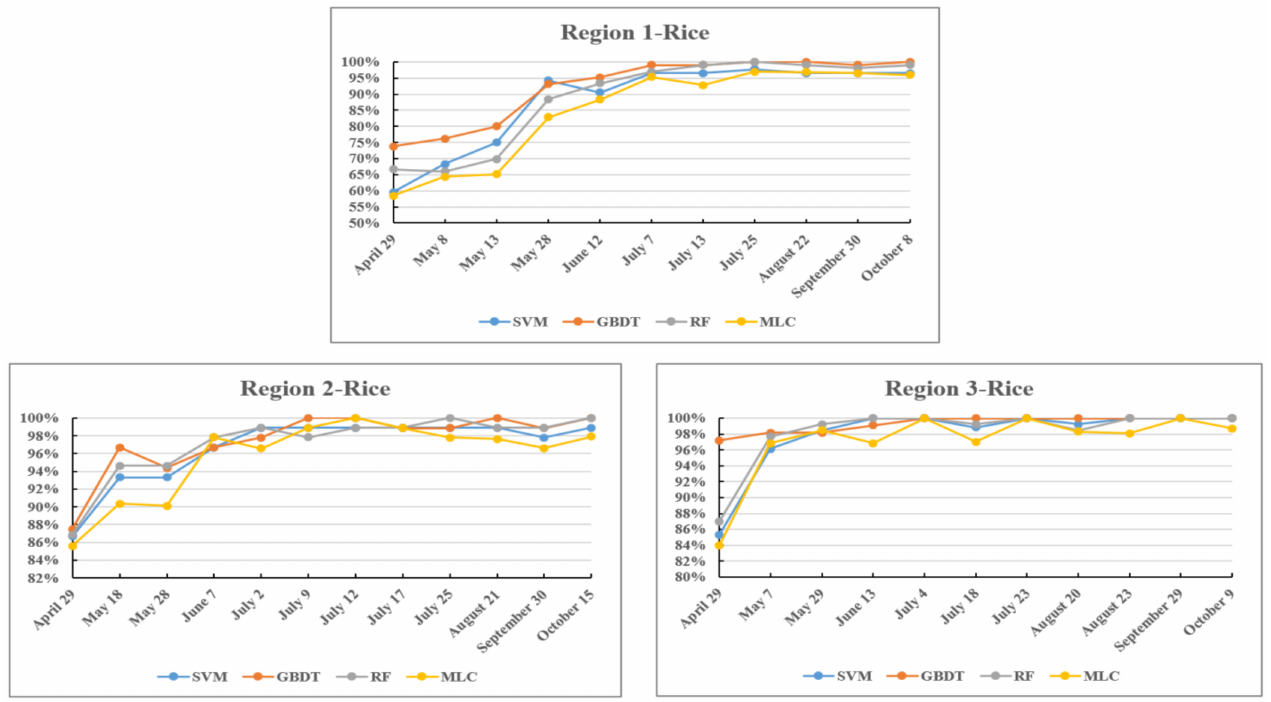
Figure 10. The recognition accuracy of rice in different periods in the three study